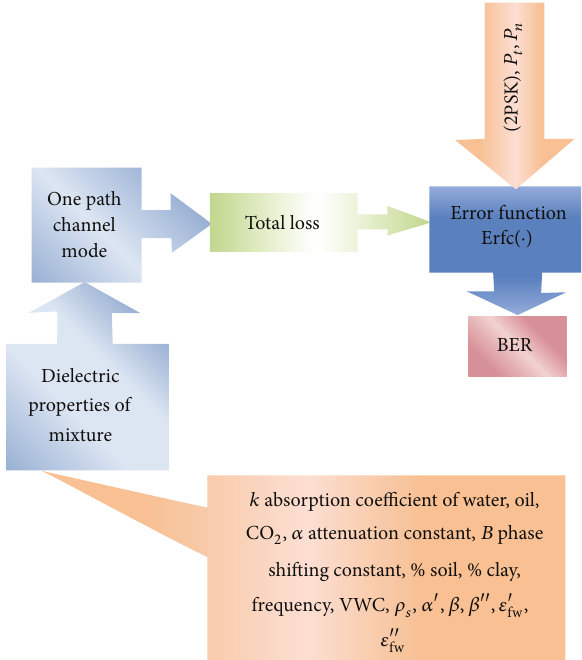
Figure 9: Propagation channel model for complex underground oil